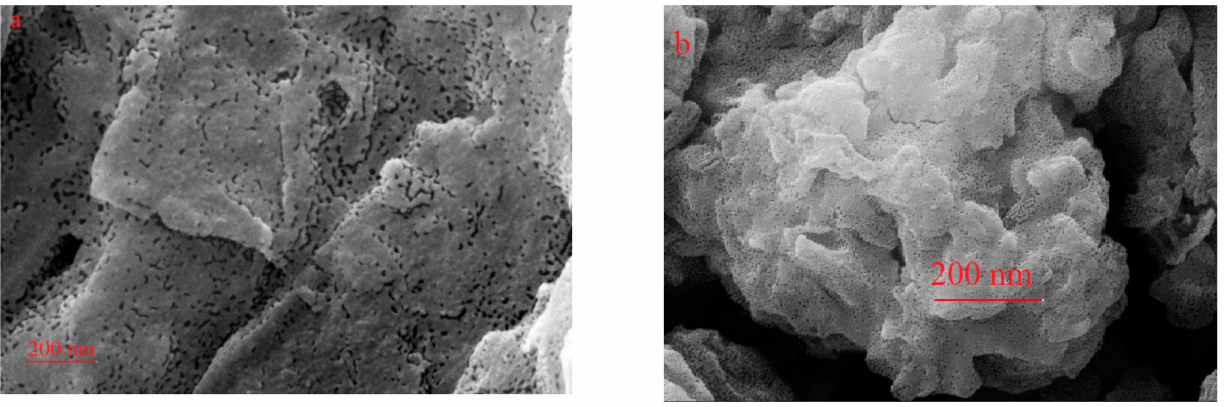
Figure 5. FESEM pictures with different magnifications of PIL(low)@TiO 2 @m-GO, ( a ) chain of poly ionic Liquid on m-GO layers; ( b ) m-Go layers coated with polymer chains from another